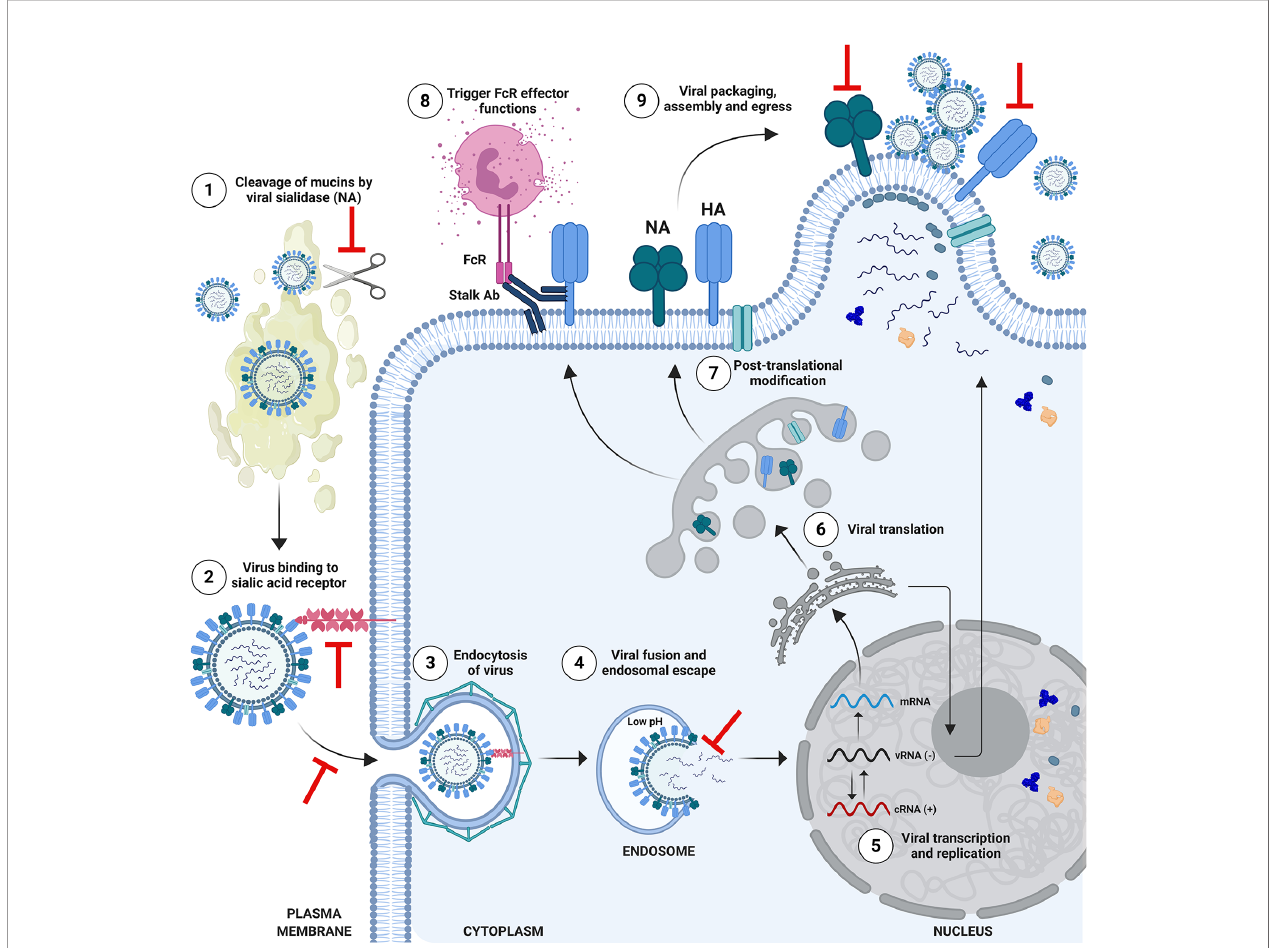
FIGURE 3 | Schematic of In fl uenza Virus Life Cycle and Targets for Protective Antibodies. The life cycle of in fl uenza viruses has several major steps in which inhibition by neutralizing or protective antibodies can occur. (1) Viral entry in the respiratory tract is facilitated by the enzymatic activity of the viral neuraminidase (NA), which cleaves mucins to allow access to respiratory cells. Anti-NA antibodies, or anti-hemagglutinin (HA) antibodies which block the enzymatic function of NA could potentially inhibit this process. (2) Viral entry is mediated by binding of the head of HA to sialic acid receptors on the surface of cells, followed by endosomal escape by fusion of the viral and endosomal membrane. Antibodies which bind to the HA head domain can block this interaction and can confer sterilizing protection from infection. (3) Alternatively, neutralizing antibodies against HA can block the post-binding internalization of in fl uenza virus, or (4) its ’ ability to fuse and escape from the endosome. (5) Viral ribonucleoproteins (vRNPs) are imported into the nucleus for viral transcription and replication. (6) mRNAs exported to the cytoplasm for translation. (7) HA and NA are traf fi cked to the Golgi for post-translational modi fi cation and subsequent presentation on the cell surface. Selected proteins return to the nucleus to participate in viral replication. Progeny vRNPs are exported out of the nucleus towards the plasma membrane for subsequent assembly and virion formation. (8) Anti-HA stalk antibodies can recognize HA on the surface of infected cells and engage Fc-mediated effector functions such as antibody-dependent cellular cytotoxicity, targeting the infected cell for degradation. (9) Viral packaging, assembly and egress takes place at the plasma membrane. This process can also be a target for anti-HA or anti-NA antibodies, which block egress. Anti-NA antibodies can do this by preventing new virions from being released from the surface of infected cells, or by the absence of NA activity causing new virions to aggregate. Figure is adapted from Krammer, 2019 (4). Note: icons are not to scale. HA stalk is trimeric ( not shown ) and NA stalk is tetrameric ( not shown ). Figure created with © BioRender -